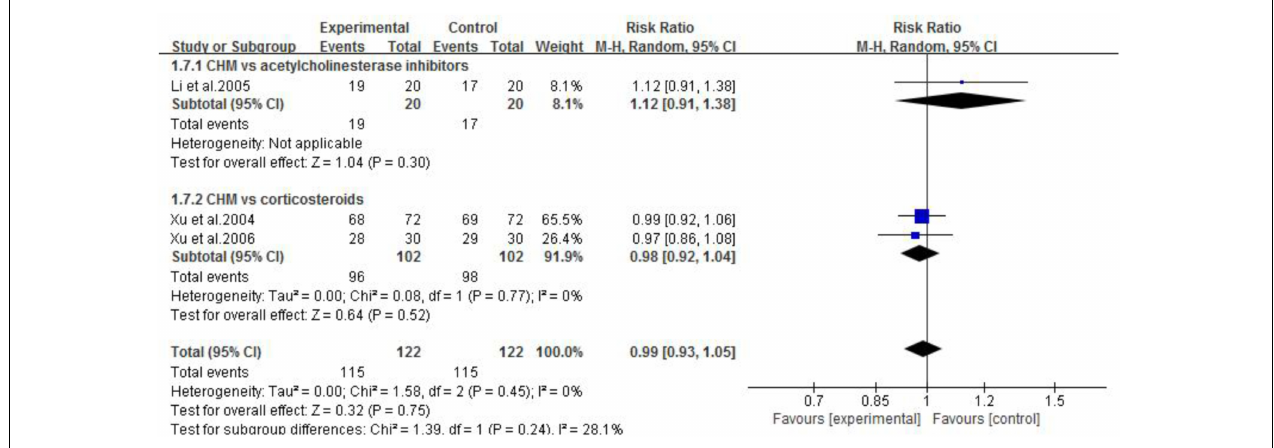
FIGURE 2 | The forest plot: The total clinical effective rate of CHM vs. WCM.